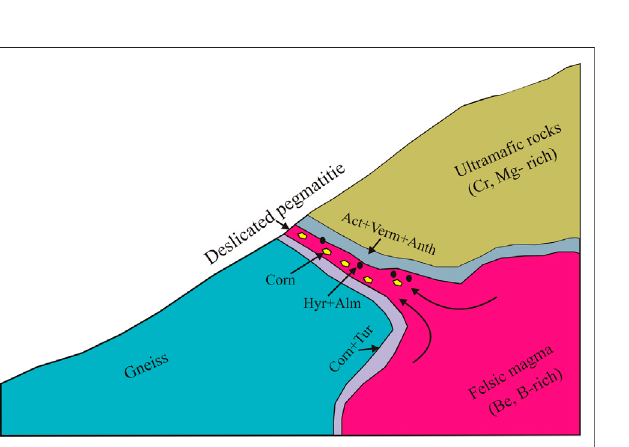
Frontiers in Earth Science |